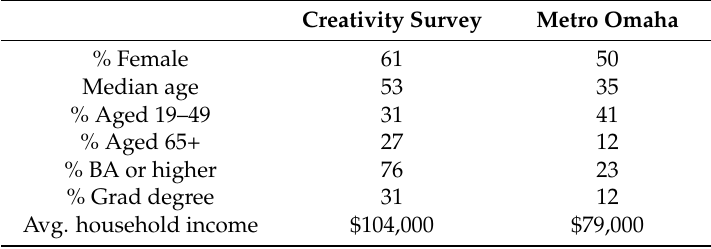
Table 2. Demographics of survey respondents vs. residents of the Omaha metropolitan